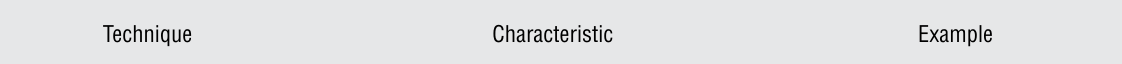
Table 2 - Laparoscopic fascial wound closure techniques. Technique